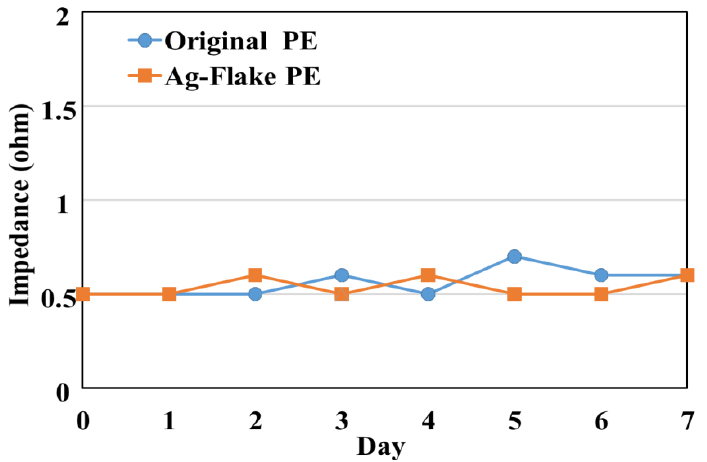
Figure 4. The variation of surface impedance of dry PEs in the temperature and humidity test with 85% RH at 80 °C for one week.